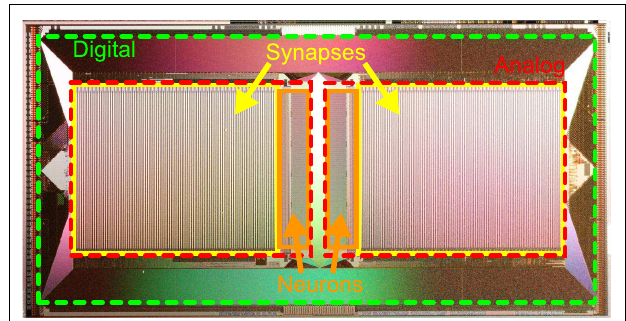
FIGURE 1 | Photograph of the HICANN (High Input CountAnalog Neural Network) chip, the basic building block of the FACETS wafer-scale hardware system. Notice the large area occupied by mixed-signal synapse circuits (yellow boxes) compared to neuron circuits (orange boxes). A digital communication infrastructure (area between red and green boxes) ensures a high density of connections between neurons on the same and to other HICANN chips.